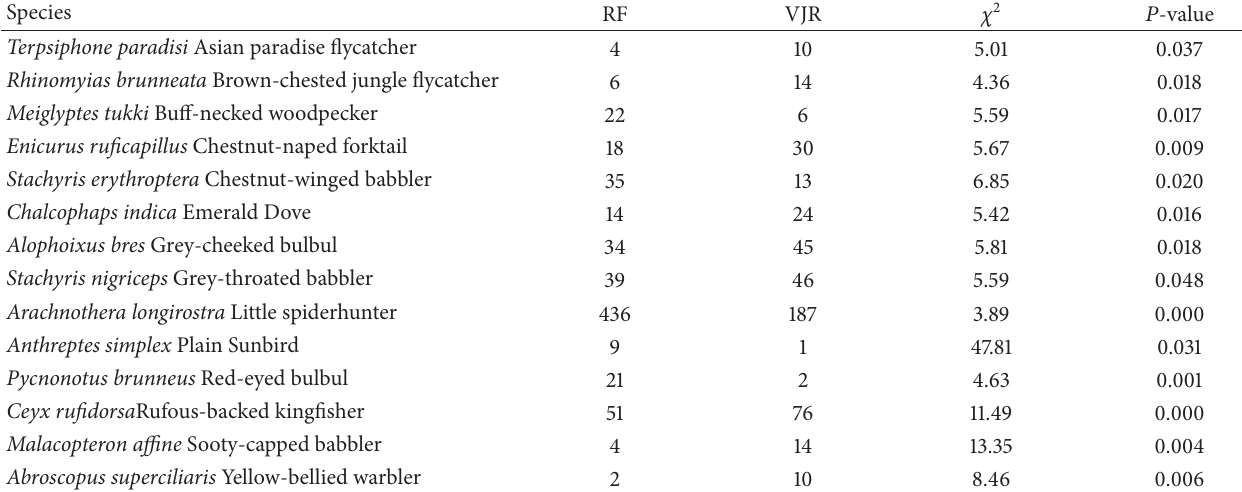
Table 2: List of common understorey bird species which show different abundance in RF and VJR across both study sites using Chi-squared test ( 𝜒 2 ).